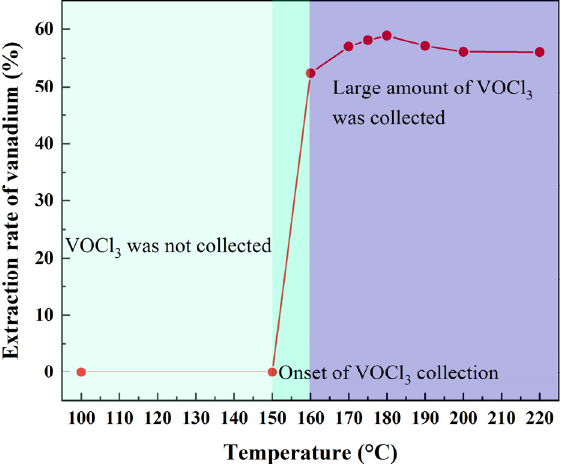
Figure 6. E ff ects of chlorination temperature on the extraction rate of